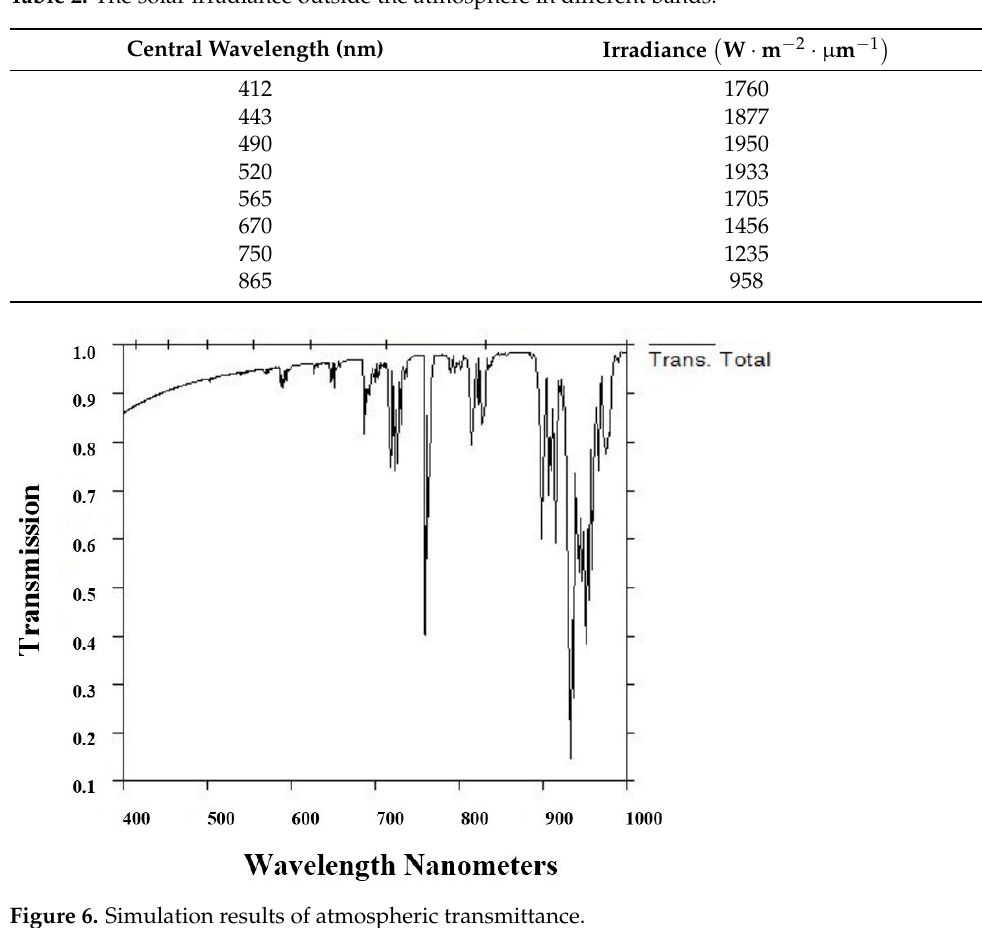
Figure 6. Simulation results of atmospheric transmittance.